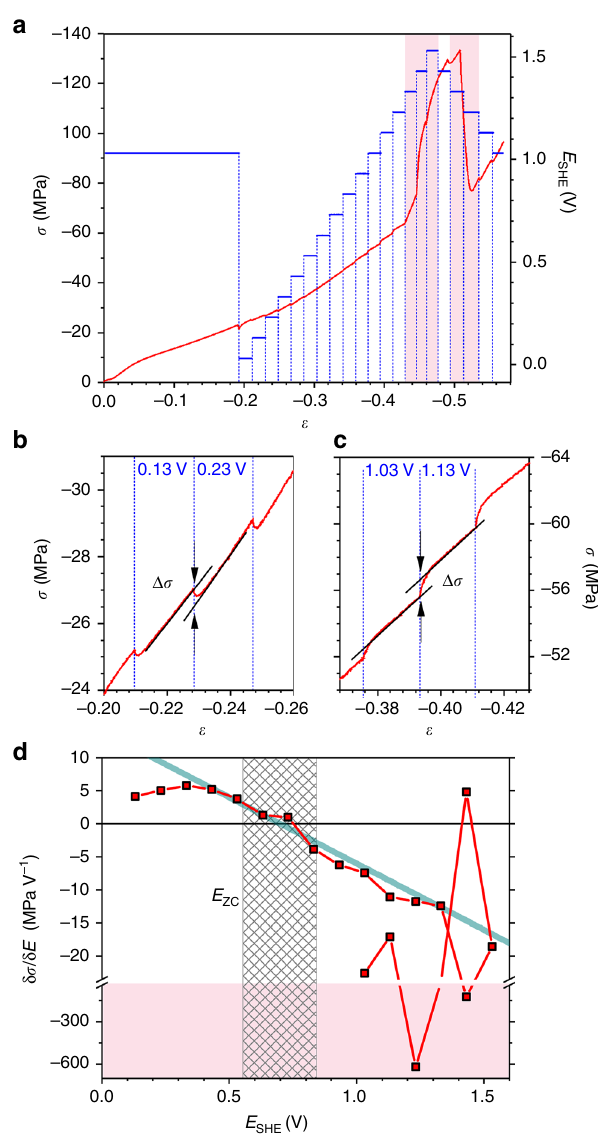
Fig. 4 Results of an in situ compression test. a Red, stress σ vs. strain ε at constant engineering strain rate 10 − 5 s − 1 . Potential, E , vs. SHE ( blue ) is superimposed. b , c Details from a , showing increase or decrease of σ in response to potential steps during capacitive charging. d Response, parameterized as δ σ / δ E , of experimental fl ow stress to jumps in E . Note axis break and different scales for the capacitive-regions and OH-regions. Blue solid line: predicted response, Eq. (12); note excellent agreement near potential of zero charge, E zc . Hatched: experimental range of E zc . Red shaded regions in a , d denote regimes of OH-adsorption/desorption. Test in 0.5 M H 2 SO 4 , mean ligament diameter 40